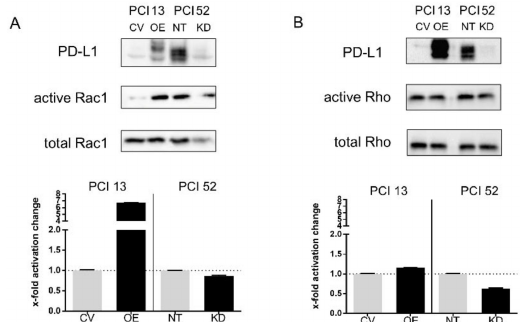
Figure 5. PD-L1-dependent modulation of Rho-GTPase activation states. ( A ) PD-L1-dependent activation of small GTPases Rac1 and Rho. Western blot analysis of cell lysates from Rho-GTPase pulldown assays of PD-L1-overexpressing PCI 13 and PCI 52 with siRNA knockdown of PD-L1. Transfection with nontargeting siRNA was used as control (NT). A Representative WB analysis with the precipitate from Rho-GTPase pulldown assays. ( B ) Semiquantitative analysis revealed a decreased activation state of Rho in PCI 52 and an increased activation state of Rac1 in PCI 13 when compared to control. The results are expressed as means ± SD; n =